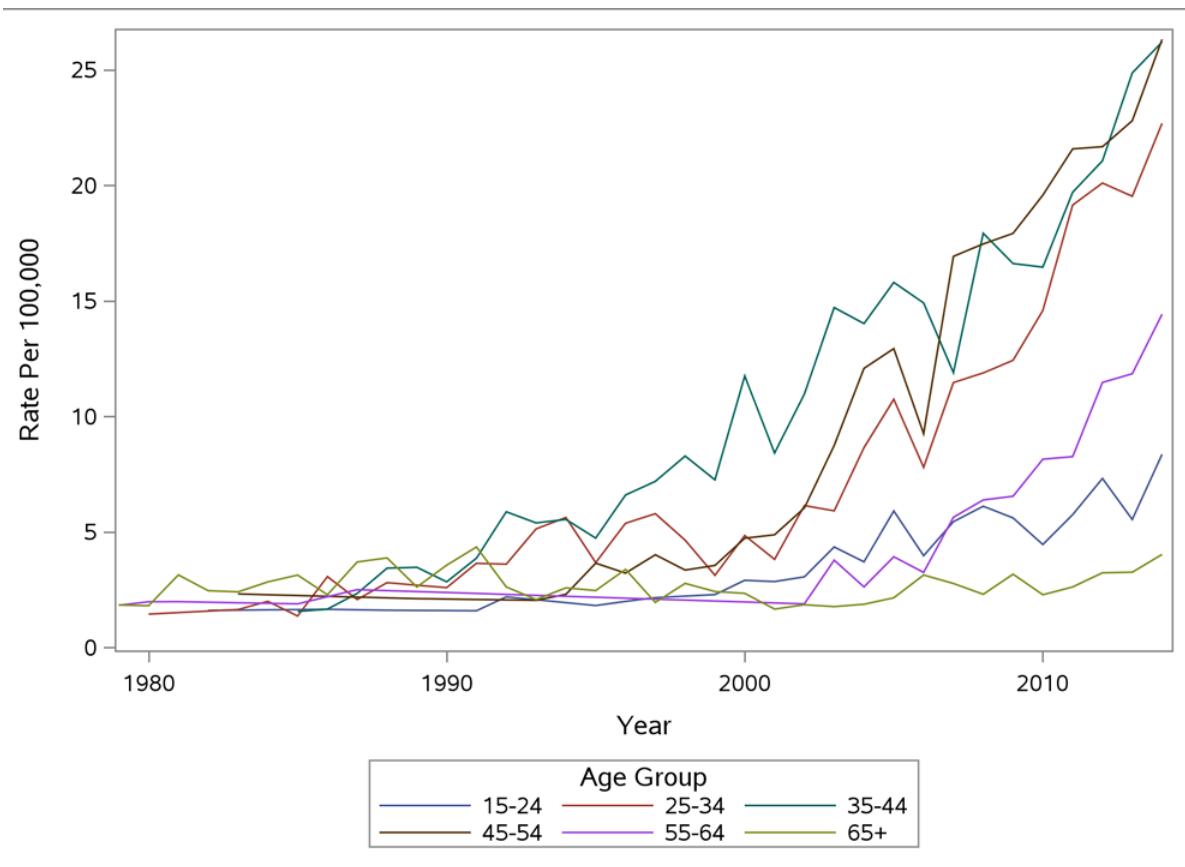
Fig 1. PA Accidental Poisoning Mortality Rate Per 100,000 Males by Age